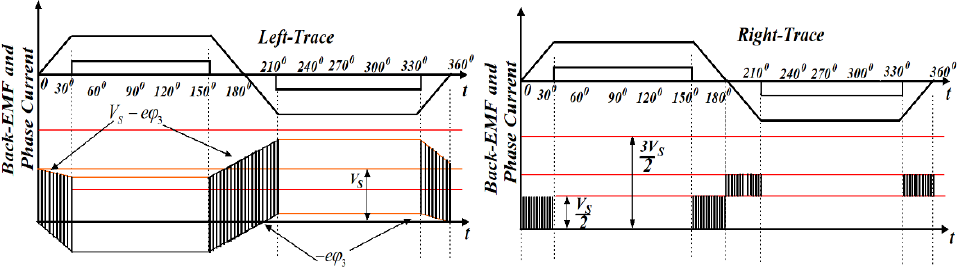
Figure 5. Waveforms of neutral point potential and back-EMF voltage (red lines indicate different voltage levels).